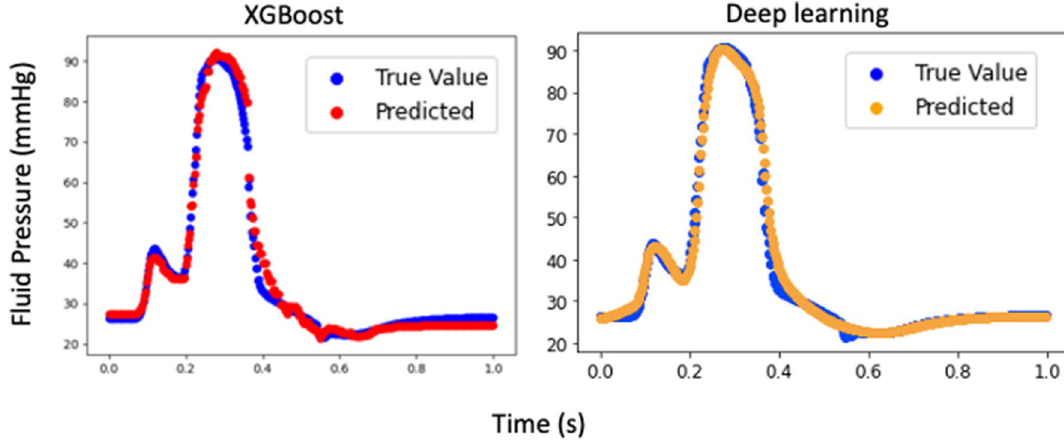
Figure 5. Comparison between XGBoost and feed forward DL. The XGBoost result is reproduced from our previous paper 10 .